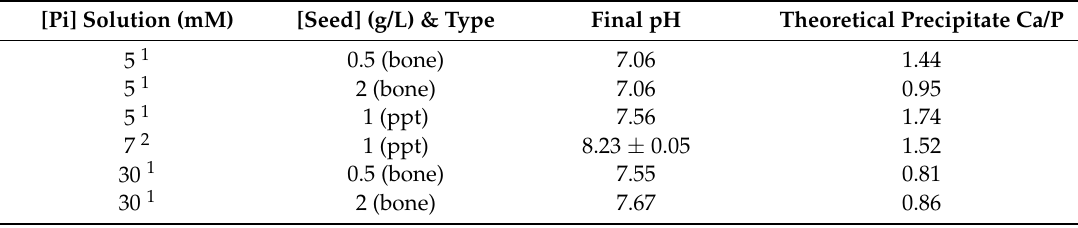
Table 7. Summary of pH and theoretical Ca/P results for the batch, seeded precipitation tests.